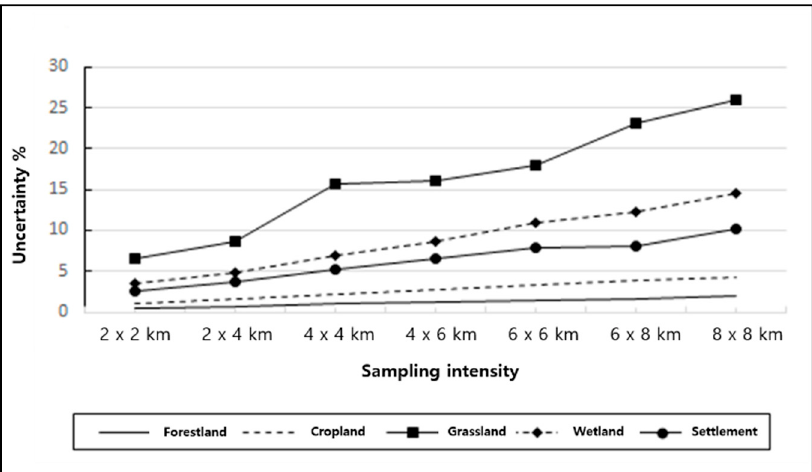
Figure 2. Uncertainty of each land-use category by sampling intensity.